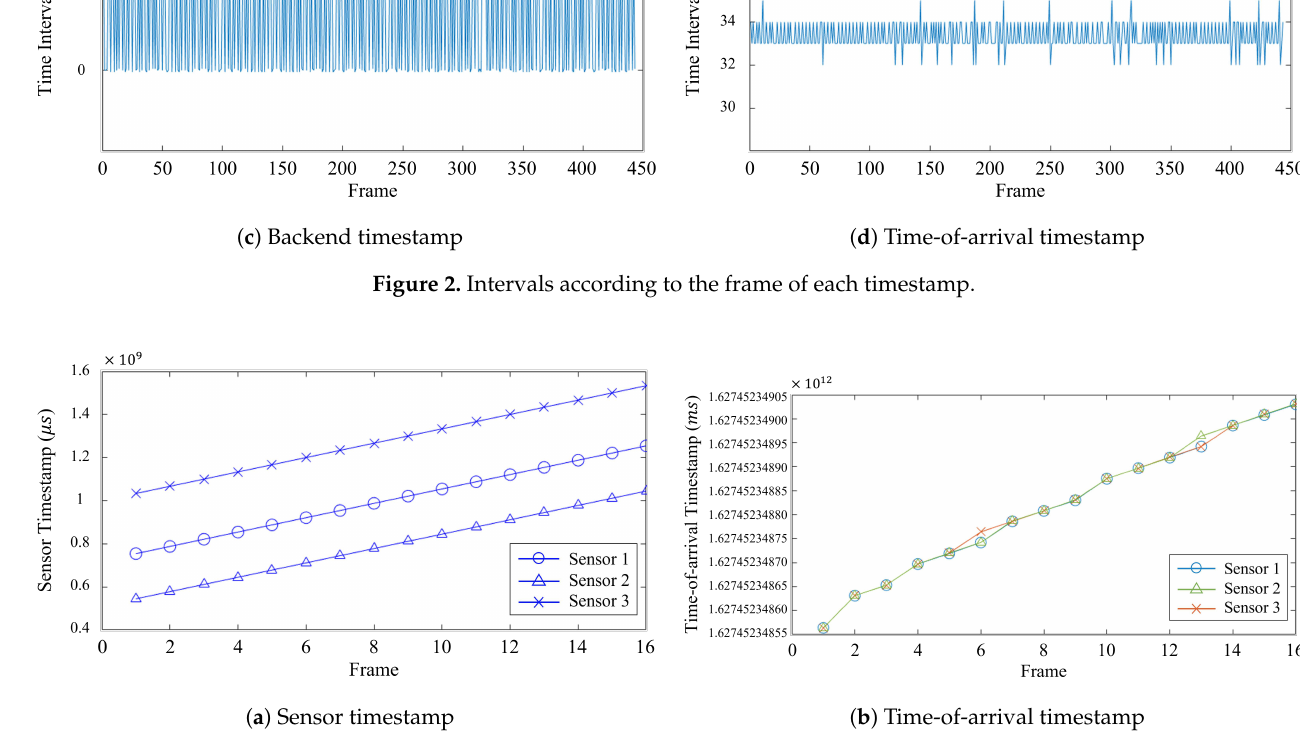
Figure 3. The sensor and time-of-arrival timestamps of each